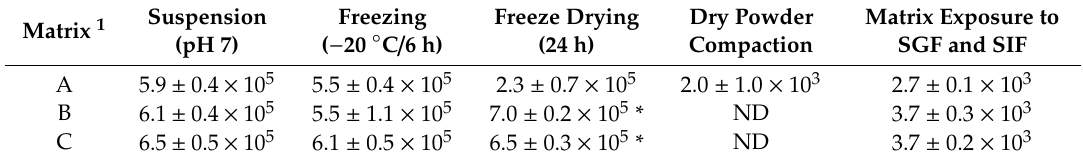
Table 1. Viability of BCG (colony-forming units (cfu)) at each stage of matrix production (data represent mean ± SD, n = 3). For each matrix, 100 µL of BCG stock (1.48 ± 0.14 × 10 8 cfu/mL) was used, representing a starting BCG quantity of 1.5 × 10 7 cfu.